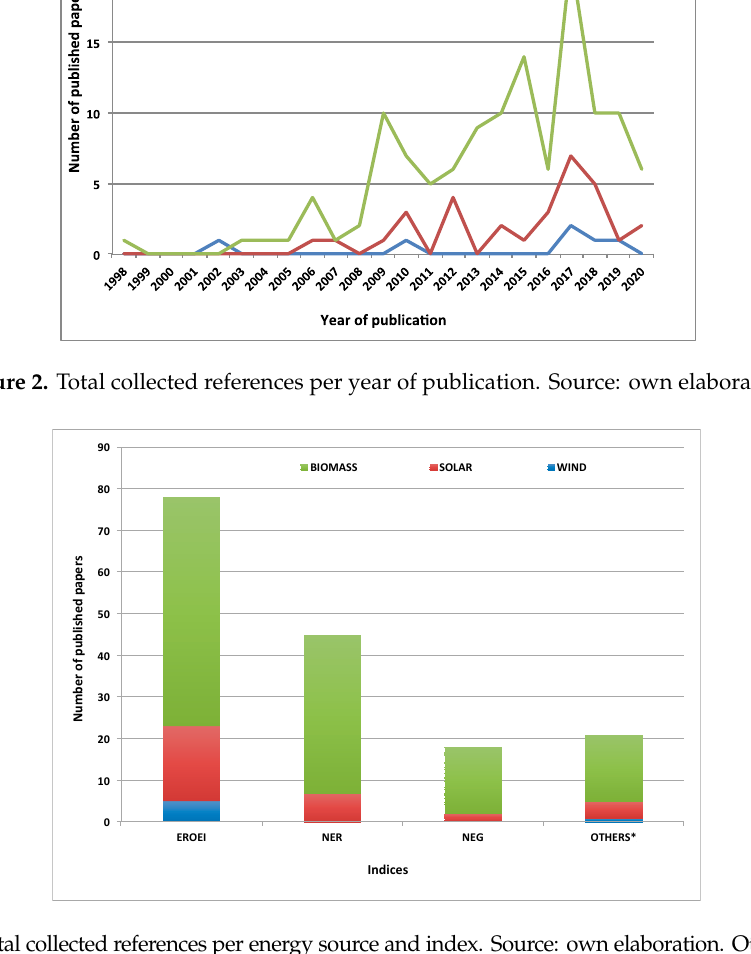
Figure 3. Total collected references per energy source and index. Source: own elaboration. Others*: papers including more general measures such as net energy, energy efficiency and energy balance.